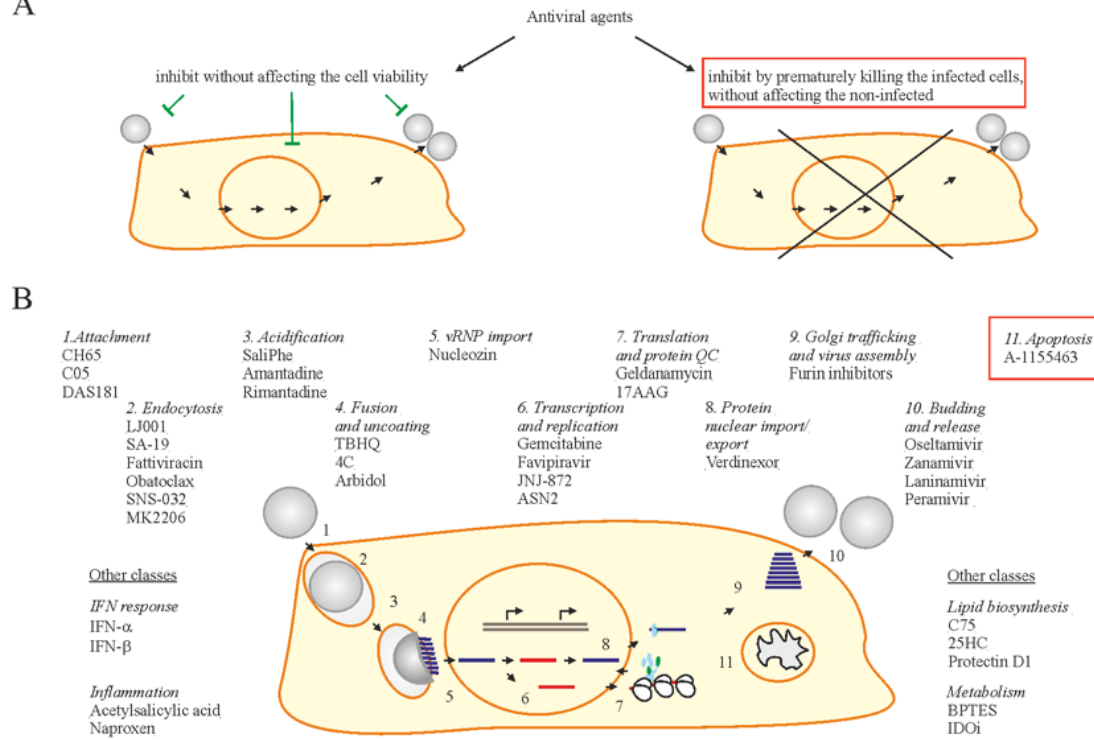
Figure 3. Two strategies of antiviral drug development. ( A ) One strategy is focused on discovery of antivirals to inhibit viral infection without affecting the viability of infected cells, whereas another exploits small molecules to inhibit viral replication by specifically killing only the virus-infected cells. ( B ) Examples of existing and emerging anti-IAV drugs. Existing and emerging drugs that target certain stages of virus replication cycle are shown. Bcl2 inhibitors (Bcl2i) are shown in a red box.